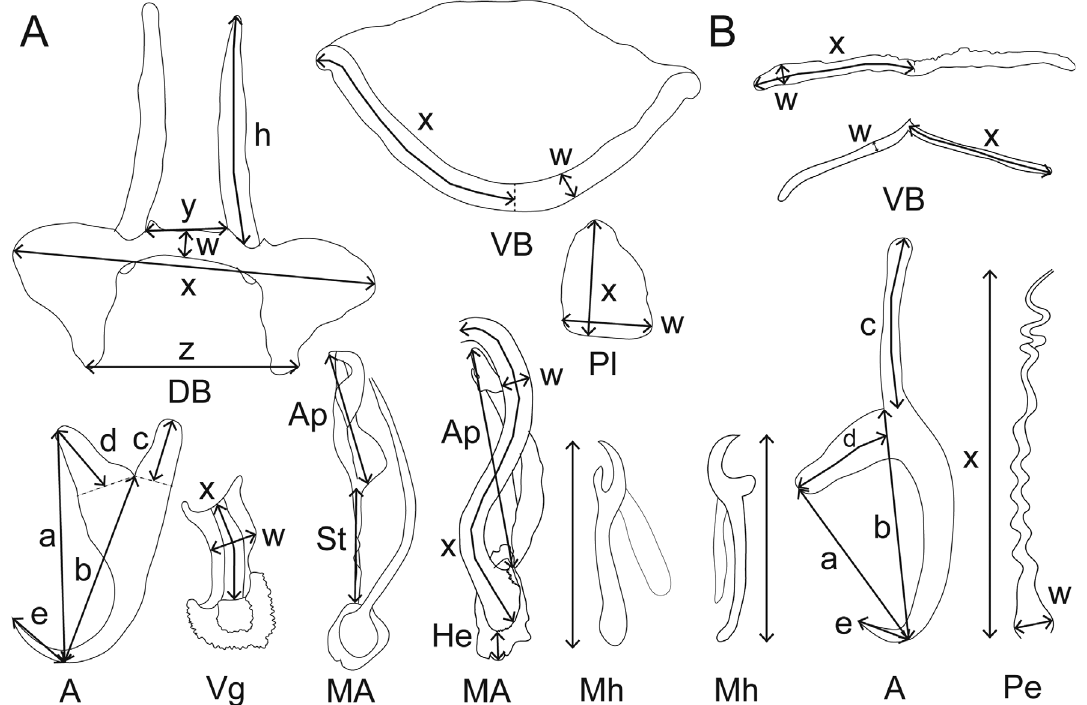
Figure 2. (A – B) Measurements studied. (A) Measurements used to study Cichlidogyrus spp. and Scutogyrus spp. DB dorsal bar: h , length of dorsal bar auricle; w , dorsal bar maximum width; x , dorsal bar total length; y , distance between auricles; z , dorsal bar base end length. A anchor: a , anchor total length; b , anchor blade length; c , anchor shaft length; d , anchor guard length; e , anchor point length. Vg vagina: x , vagina total length, w , vagina maximum width. MCC male copulatory complex: Ap, accessory piece straight length; St, stalk length; He, heel straight length; Pe, penis: x , penis total curved length; w , penis maximum width. Pl auxiliary plate: x , auxiliary plate total length; w , auxiliary plate maximum width. H hook straight length. VB ventral bar: w , ventral bar maximum width; x , length of one ventral bar branch. (B) Measurements used to study Enterogyrus spp. VB ventral bar: x , length of one ventral bar branch; w , ventral bar maximum width. A anchor: a, anchor total length; b , anchor blade length; c , anchor shaft length; d , anchor guard length; e , anchor point length. Pe penis: x , penis total curved length; w , penis base maximum